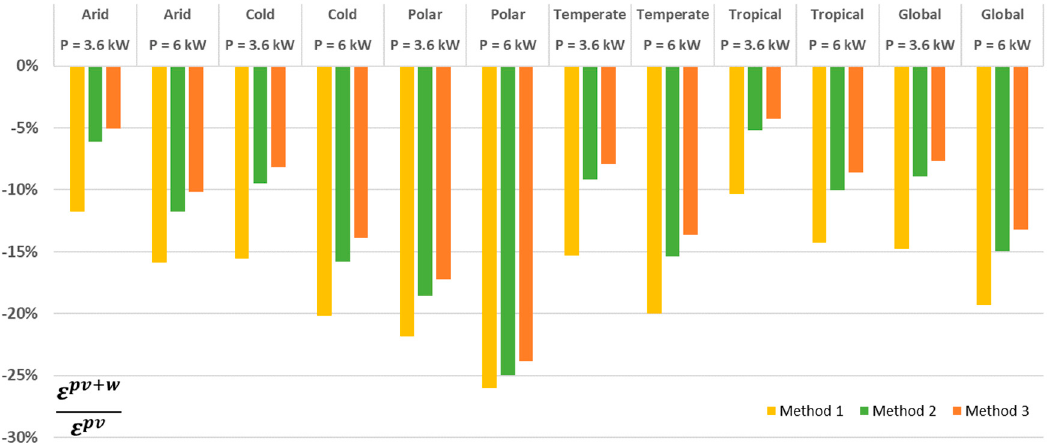
Figure 16. Improvement of the matching factor: ε pv+w (hybrid) over ε pv (PV) facilities for different installed power capacity.